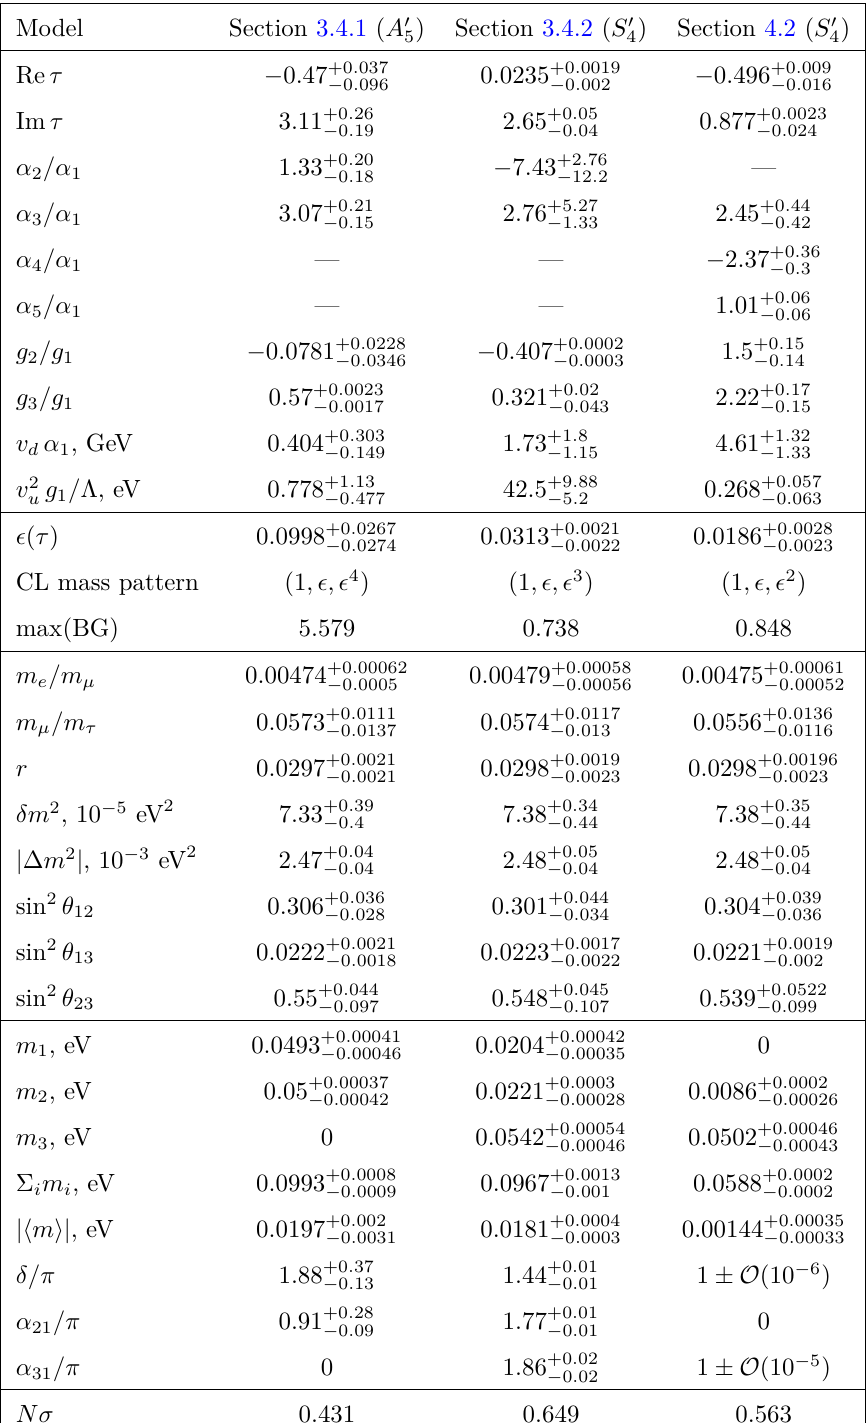
Table 5. Best-fit values and 3 σ ranges of the parameters and observables for the models discussed in sections 3.4 and